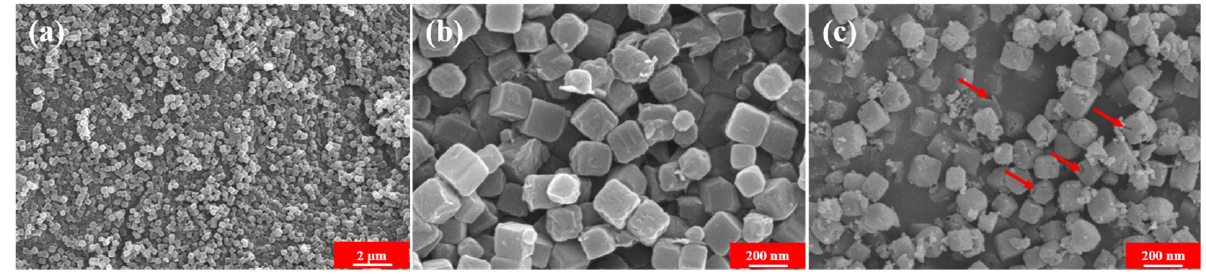
Figure 4. SEM images of solid ZIF-67 precursor ( a , b ) and CoS 2 hollow nanoboxes ( c ).